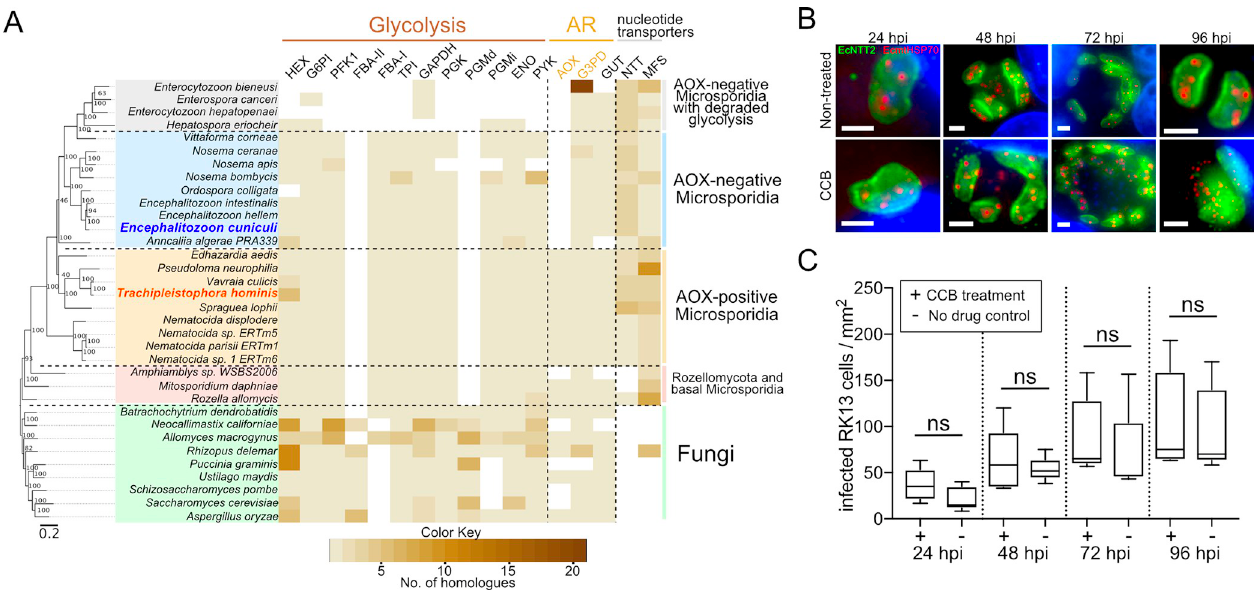
Fig 4. The AOX inhibitor CCB has no apparent effect on AOX-deficient microsporidian E . cuniculi infecting RK13 cells. (A) Heatmap representing distribution of enzymes involved in energy metabolism including glycolysis, alternative respiration (AR), and nucleotide transporters used to steal ATP from the host (NTT, and MFS) was mapped onto a species tree of Microsporidia, Rozellomycota, and Fungi. AOX-negative microsporidia including E . cuniculi were annotated in blue and grey. Presence or absence of protein homologues was verified in genomes using protein homology network analysis. The homologues of the two studied mitosomal AR proteins (AOX, G3PDH) are coloured in orange. The cytosolic glycerol-3-phosphate dehydrogenase (GUT) was indicated in black to distinguish it from the mitosomal AR enzymes. (B) Representative immunofluorescence images of the E . cuniculi cells, observed inside RK13 cells at different time points across the time course of synchronised infection in the presence of the Colletochlorin B derivative (CCB, 50 μ M), or in the non-treated control (Non-treated). Sampled time point corresponded to: nuclear division (24h), cell division (48h), spore formation (72h), infection of new host cells by newly formed mature spores (96h). The methanol-acetone fixed samples were labelled with rat antibodies against E . cuniculi NTT2 [3] (green), and rabbit antibodies against E . cuniculi mtHSP70 [11] (red). Nuclei of the parasite and the host (asterisk) were labelled with DAPI (blue), scale bars correspond to 2 μ m. (C) Box and whiskers plots of the numbers of the E . cuniculi -infected RK cells observed across a time course of infection in presence of the drug (CCB) or in the non-treated control (ND). T-test was used to test significance of the differences between the measured values (non-significant, ns).